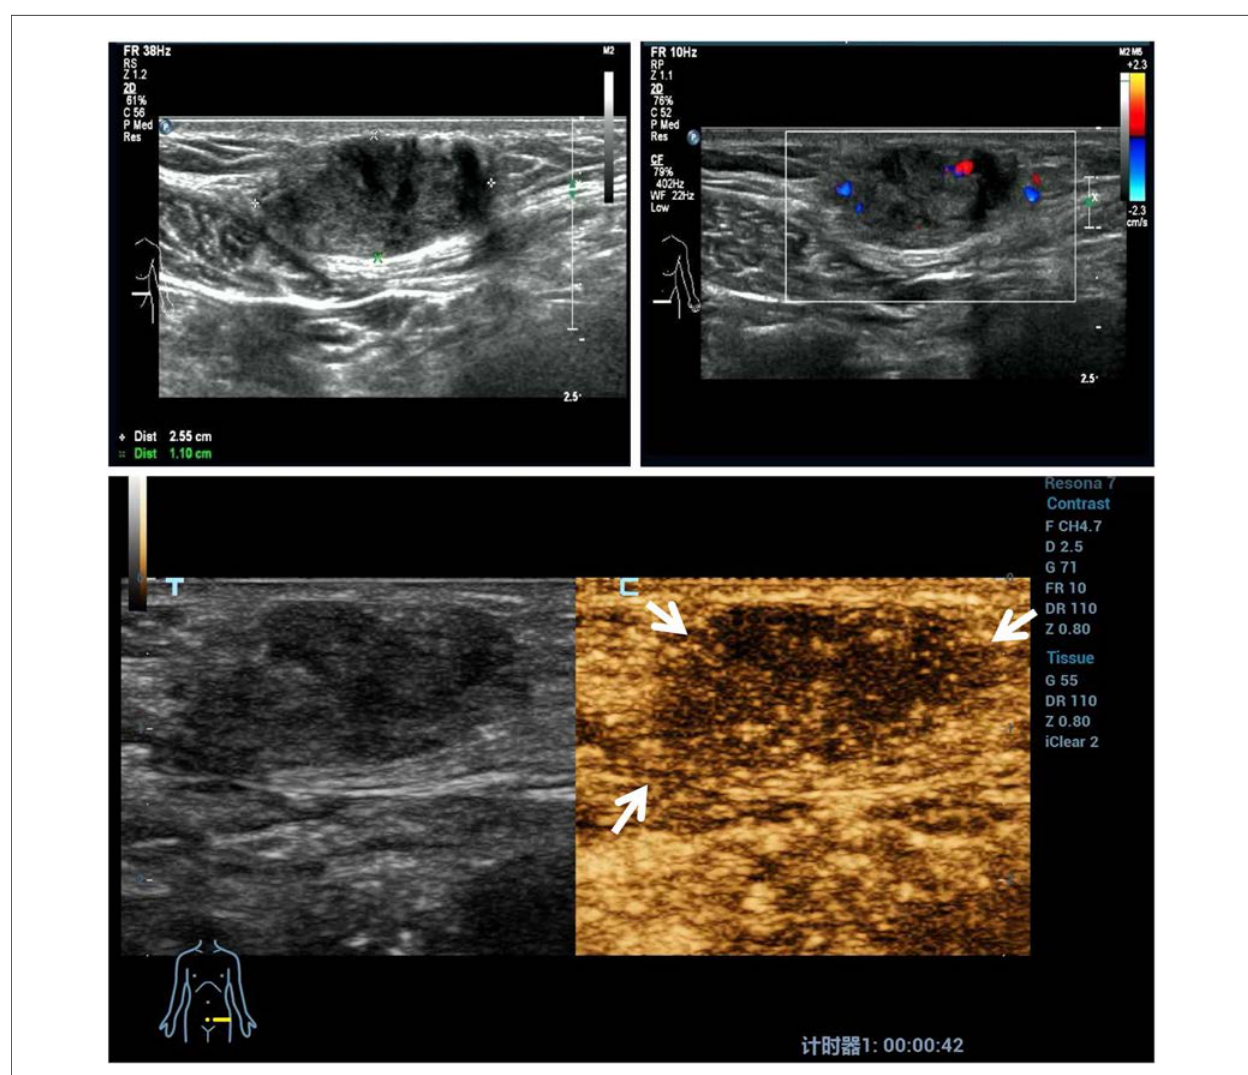
FIGURE 1 A representative case before ultrasound-guided microwave ablation. A 41-year-old patient had a hard mass on a transverse cesarean incision with cyclic abdominal wall pain. Ultrasound examination of the AWE mass revealed a heterogeneous mass with ill-de fi ned, blurred outer margins. Color Doppler ultrasound images show scarce fl ow within the mass. The contrast-enhanced ultrasound imaging of the AWE nodules shows slight perfusion compared with the surrounding tissue. AWE, abdominal wall